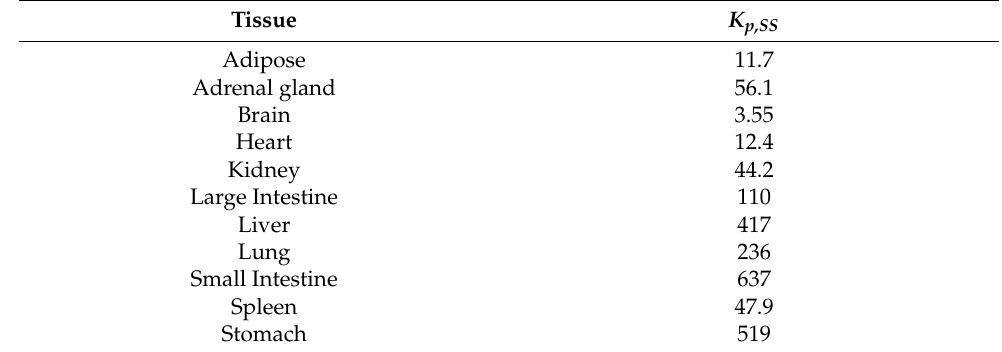
Table 2. Summary of steady state tissue-to-plasma concentration ratios of fexuprazan in 11 major tissues of